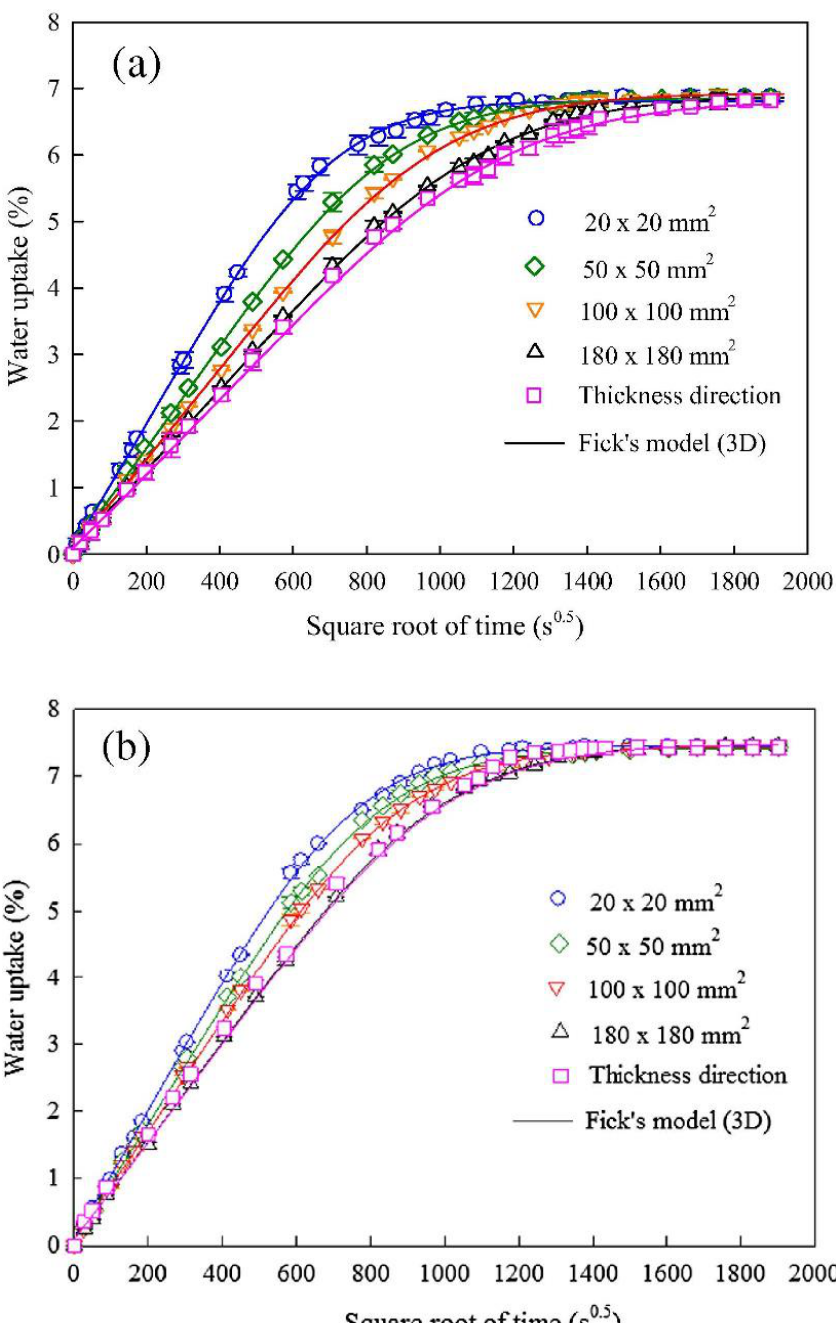
Figure 11. Unsealed samples with equal thickness and four surface dimensions aged in tap water: